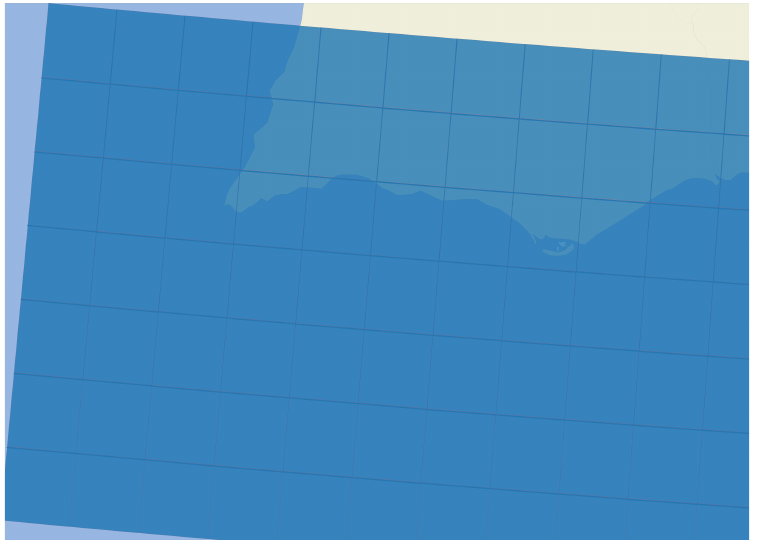
Figure 7. Example of a very wide grid, juxtaposed to the map of the southern coast of